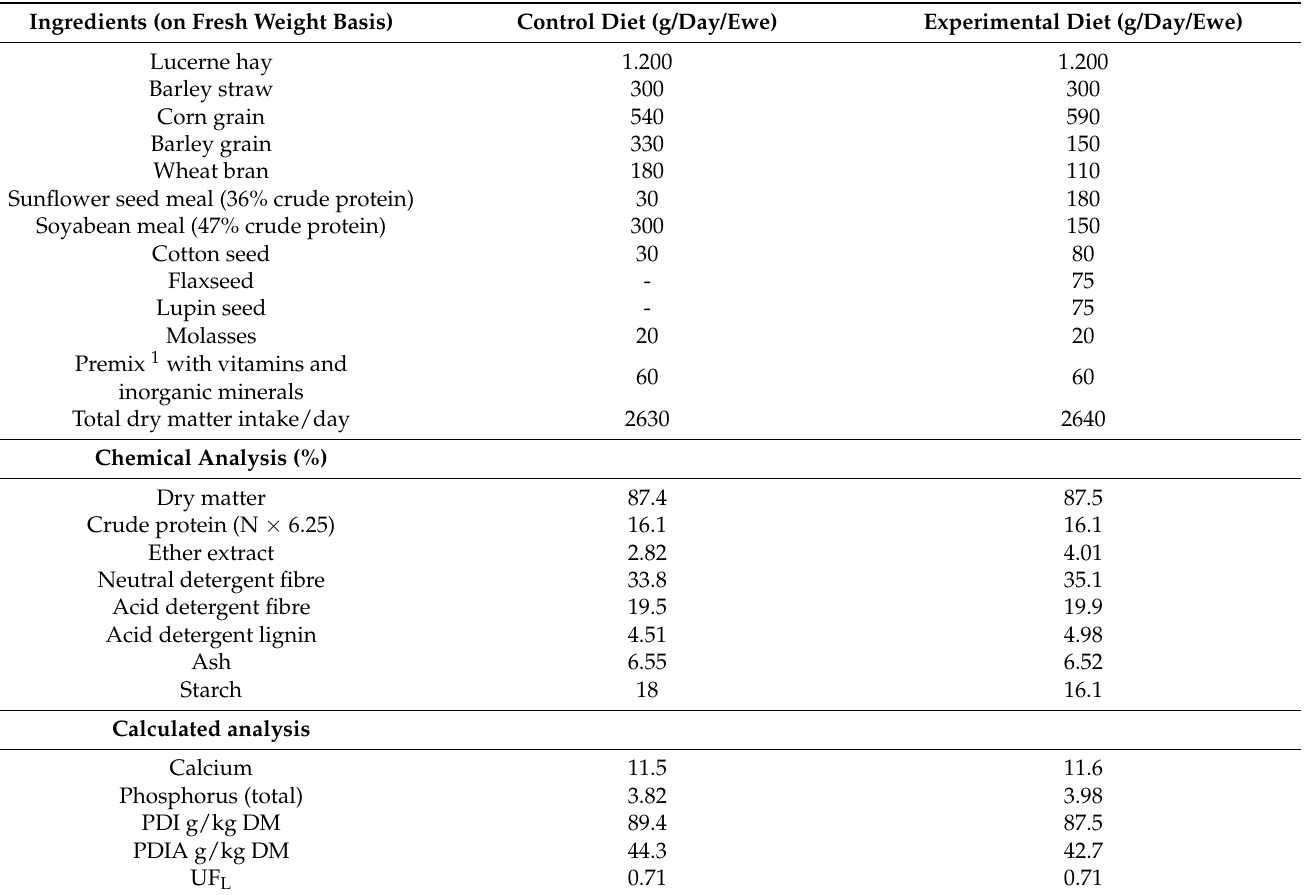
Table 1. Daily ingredient allowance and chemical composition of the diets offered to dairy ewes during the